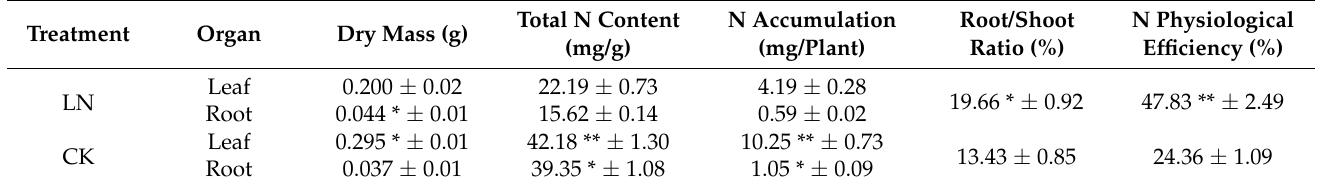
Figure 2. The root length ( A ) and photosynthetic pigment content ( B ) in rapeseed under different N treatment. The * and ** represent the statistical significances at the levels of p < 0.05 and p < 0.01, respectively. Table 1. The difference of dry mass, N content, root/shoot ratio, and N physiological efficiency between rapeseed in low and normal N